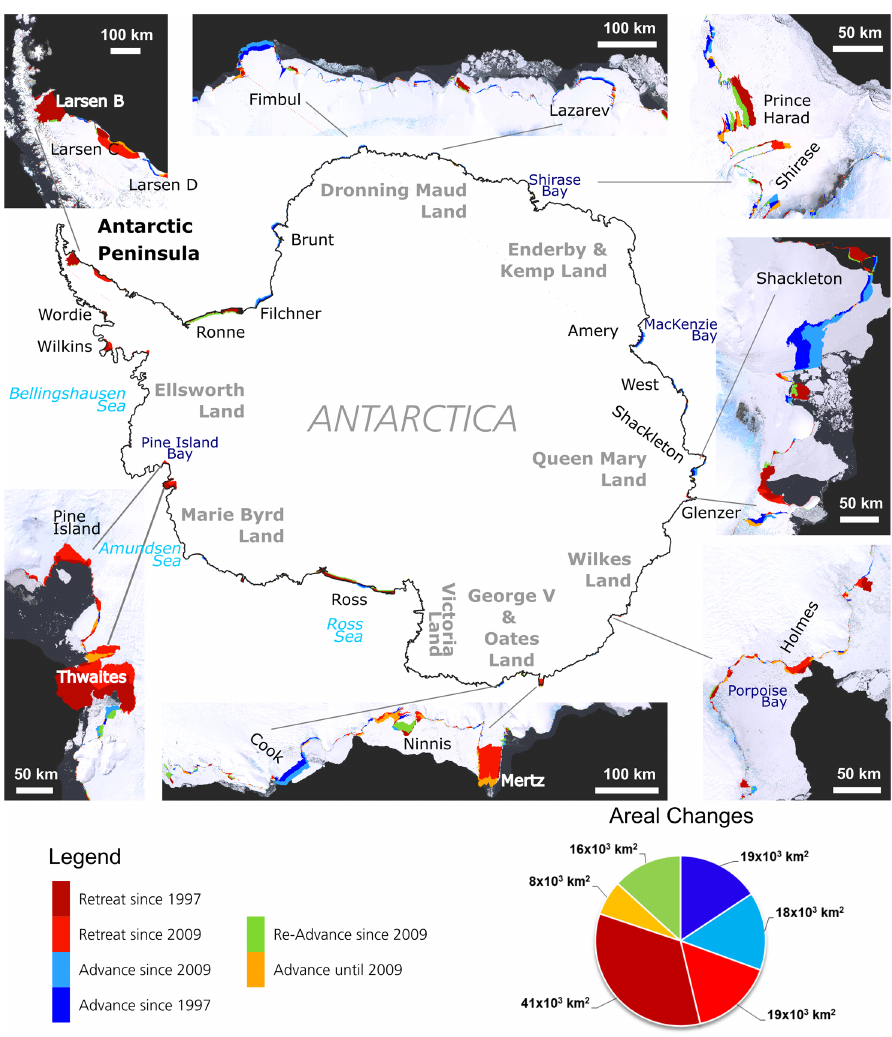
Figure 1. Coastal change in Antarctica between 1997 and 2018 with enlarged views (counterclockwise) for Larsen C Ice Shelf, Pine Island Bay, Oates Land, Wilkes Land, Shackleton Ice Shelf, Shirase Bay, and Dronning Maud Land. Colors indicate the timing of retreat and advance. The pie chart visualizes losses and gains in the area of the Antarctic Ice Sheet with regard to the indicated year. Labels of coastal sectors are shown in gray, seas in light blue, bays in dark blue, and ice shelves and glaciers in black and white fonts. Background: LIMA Landsat